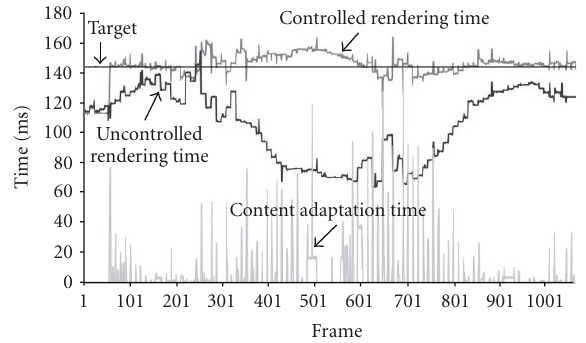
Figure 4: Content adaptation for execution time control.